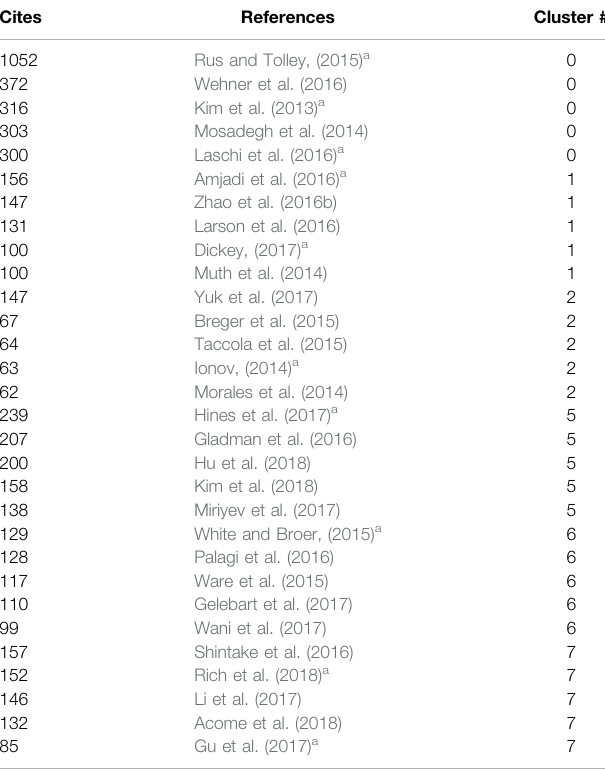
TABLE 6 | The most cited 5 references for Clusters #0, #1, #2, #5, #6, and #7,